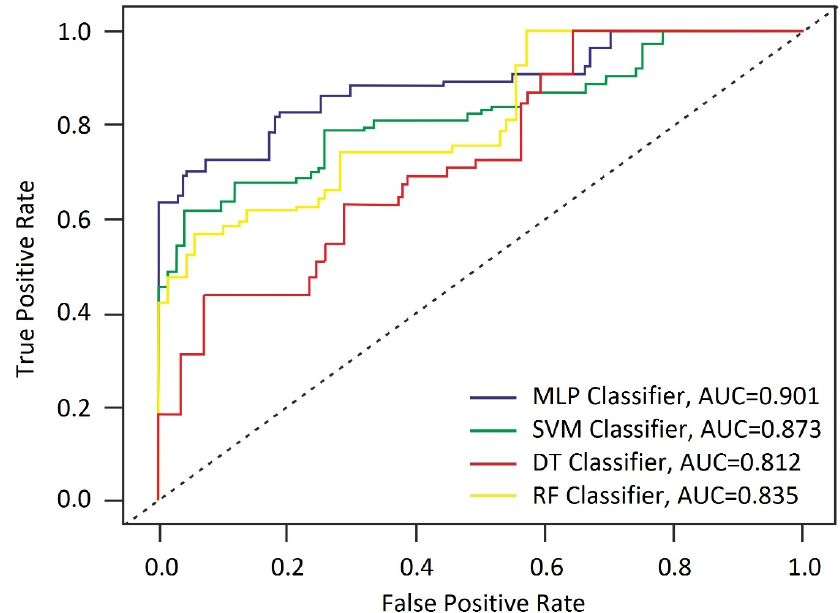
Figure 5. ROC curve analysis for different machine learning approaches.